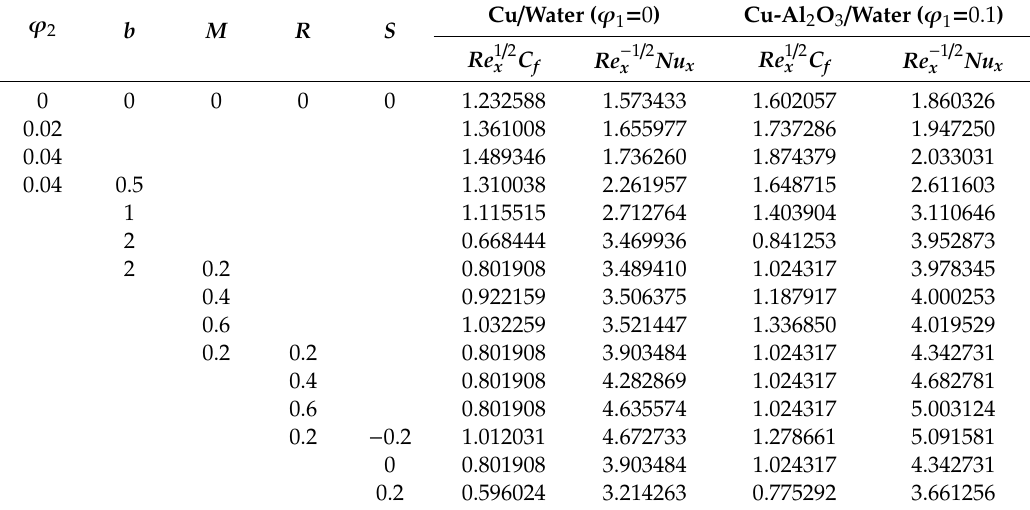
Table 5. Values of the skin friction coe ffi cient Re 1/2 x C f and the local Nusselt number Re di ff erent physical parameters when Pr =